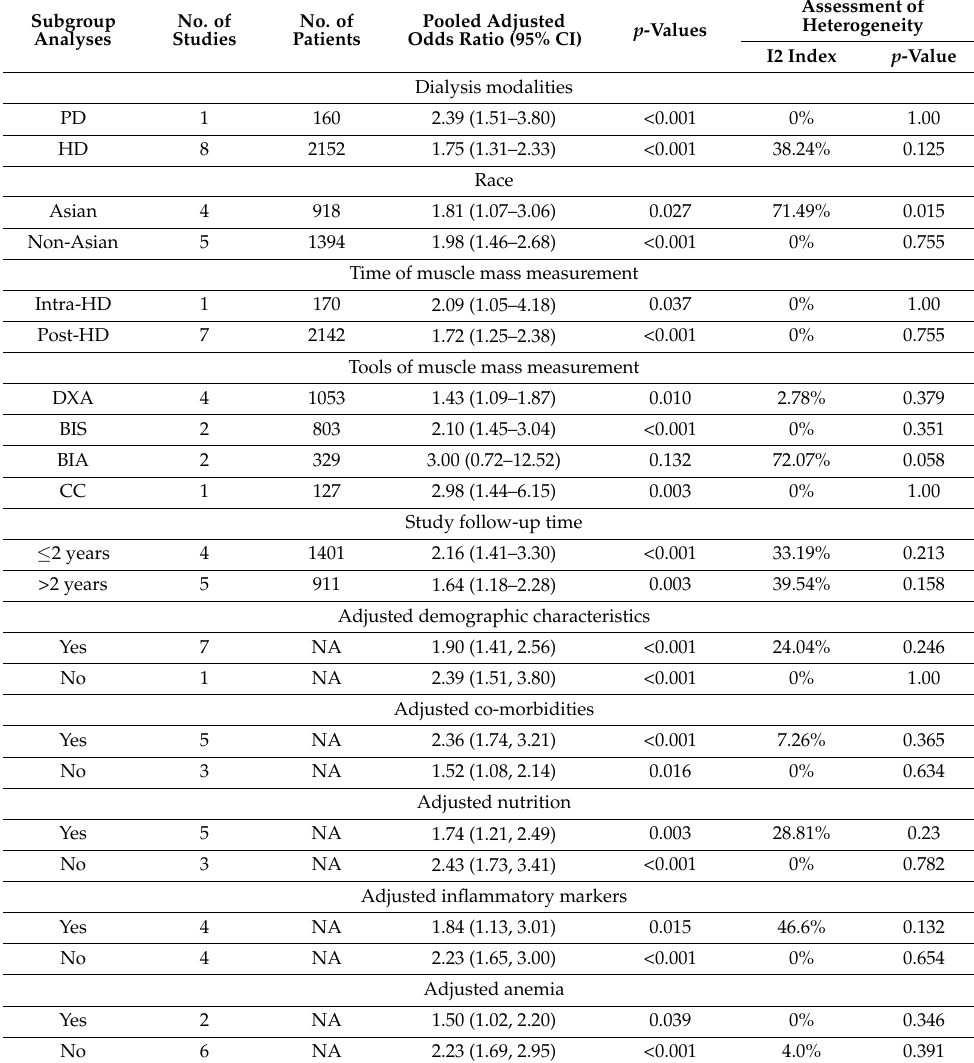
Table 5. Subgroup analyses examining the association between sarcopenia and all-cause mortality in dialysis